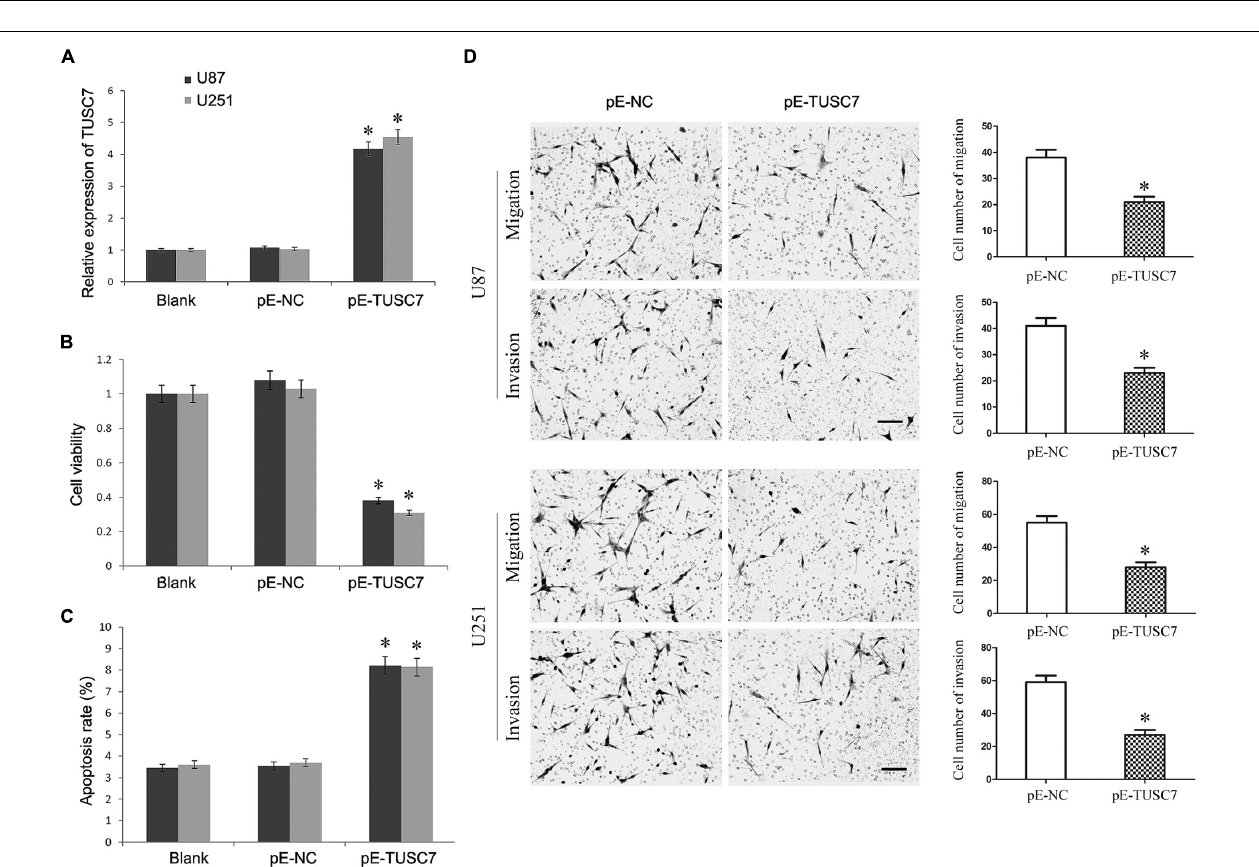
FIGURE 3 | (A) TUSC7 expression was up-regulated significant by transfection of pE-TUSC7 in U251 and U87 cell lines. (B,C) TUSC7 over-expression inhibited cell viability and advanced apoptosis of U251 and U87 cells. (D) TUSC7 over-expression impeded the migration and invasion of U251 and U87 cells, Scale bars represent 100 µ m. ∗ P < 0.05 vs. Blank and NC